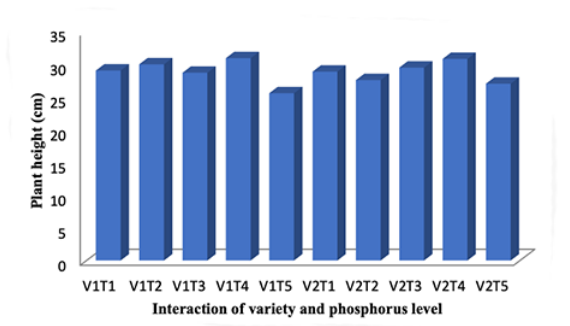
Figure 1 Interactive effect of varieties and different levels of phosphorus fertilization on mungbean